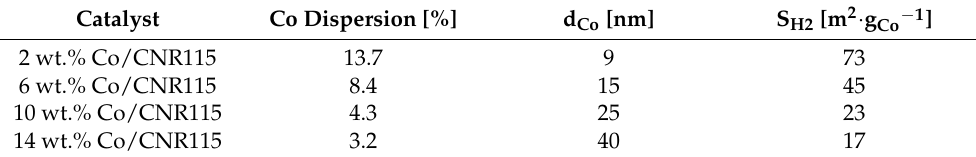
Table 2. Active phase parameters estimated on the basis of H 2 -TPD measurements.